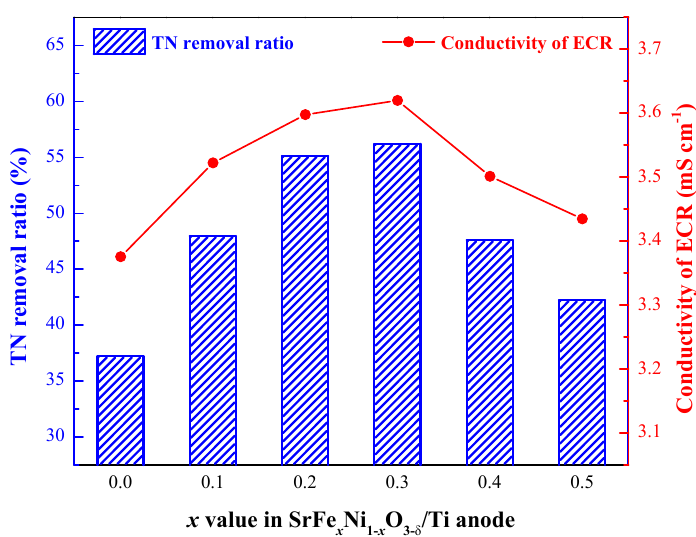
Figure 6. The effect of Fe doping content ( x value) in SrFe x Ni 1 − x O 3 − δ on the electrocatalytic properties.